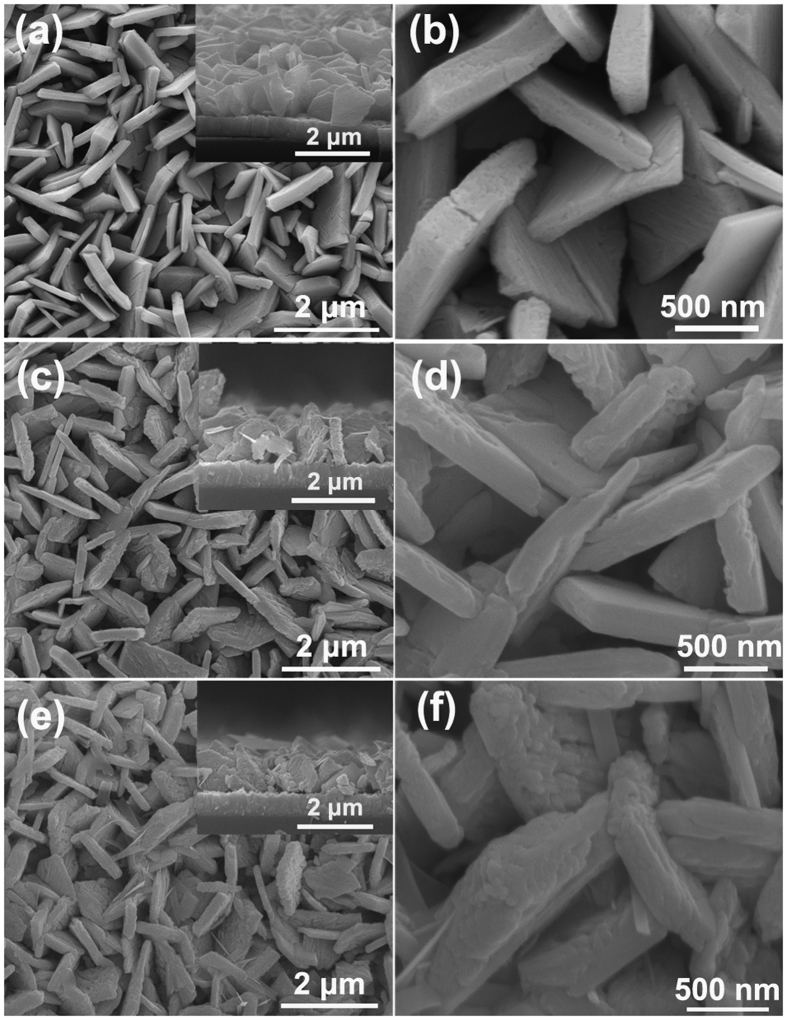
SEM images of (a,b) the WO3, (c,d) Bi2WO6/WO3 and (e,f) Bi2S3/WO3 film.